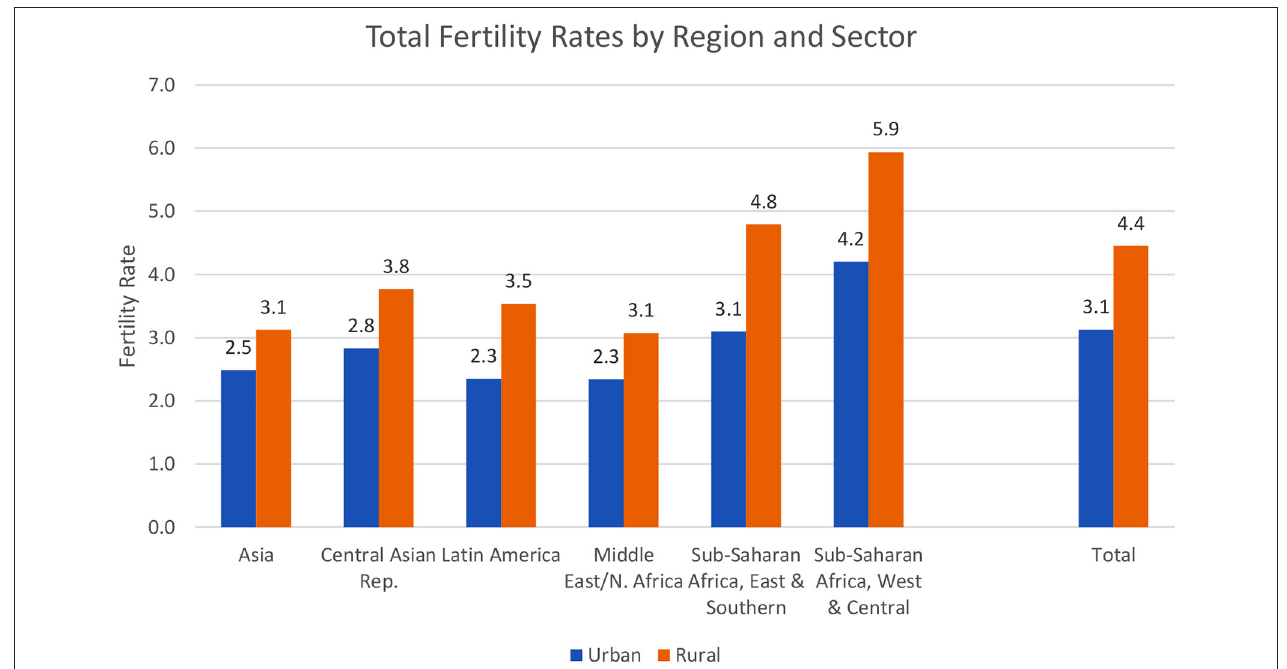
FIGURE 6 | Total fertility rates by region and sector.